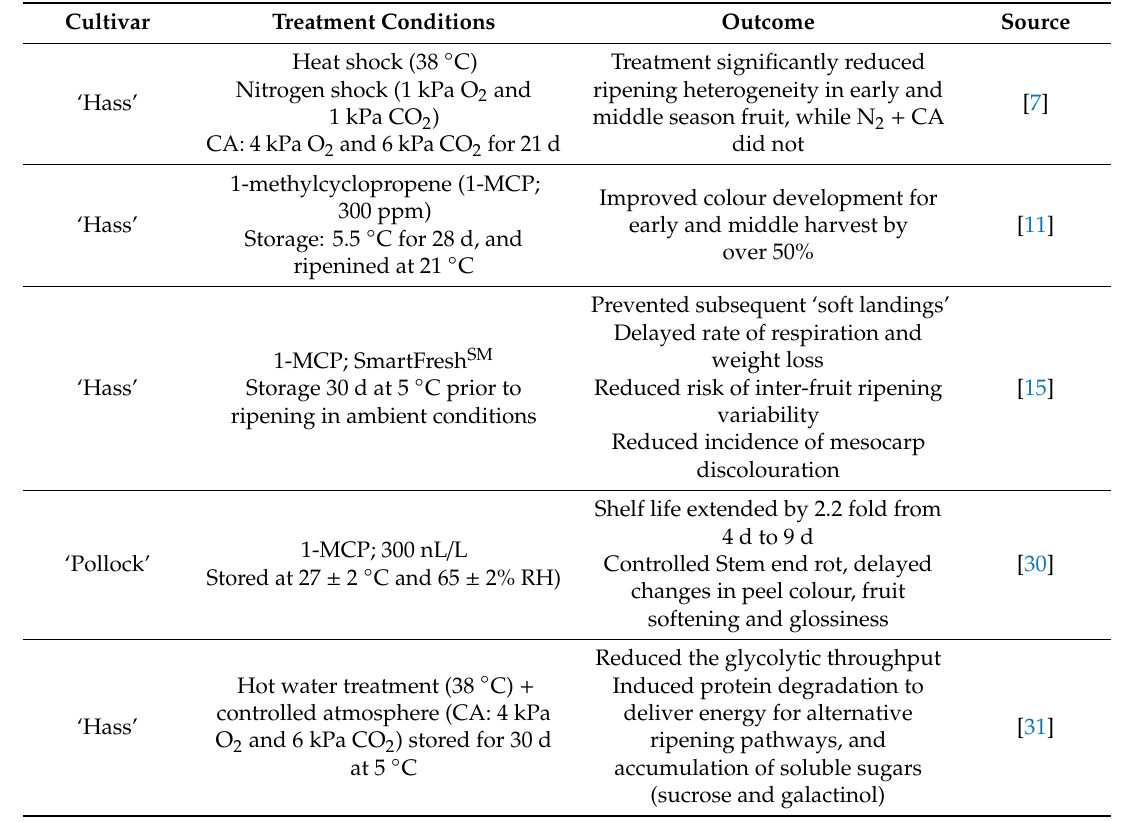
Table 1. Measures to control ripening disorders of